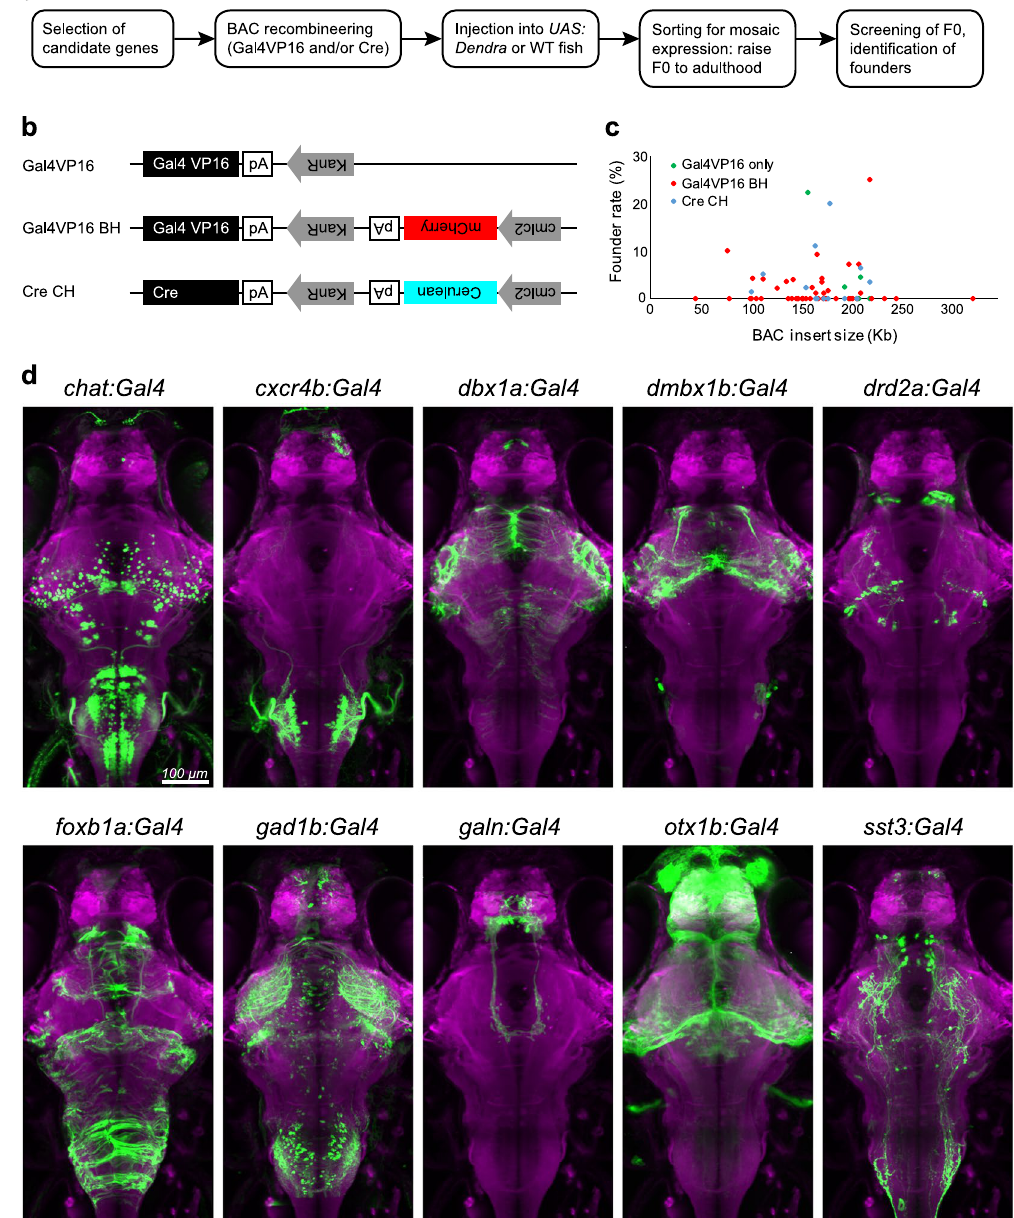
Figure 1. A candidate-based BAC screen identifies new genetic tools for targeting neuronal subpopulations. ( a ) Workflow to establish BAC transgenic fish lines. WT, wild-type. ( b ) Plasmid constructs used for BAC recombineering. KanR , kanamycine-resistant gene; pA , polyadenylation signal. ( c ) Relationship between the genomic insert length of all BAC constructs (7 Gal4VP16 BACs, 39 Gal4VP16-Bleeding Heart BACs, and 12 Cre-Cold Heart BACs) and their founder rate (percentage of germline founders out of total adult fish screened). Note that the founder rate is not correlated with the genomic insert length (R-squared = 0.0007). ( d ) Dorsal view of 6 dpf old larval brains showing the live expression pattern of ten selected transgenic Gal4 lines (green; Dendra-kras, GCaMP6s or EGFP). Brains have been registered via co-expression of HuC:lynTagRFP-T (magenta). Scale bar, 100 µ